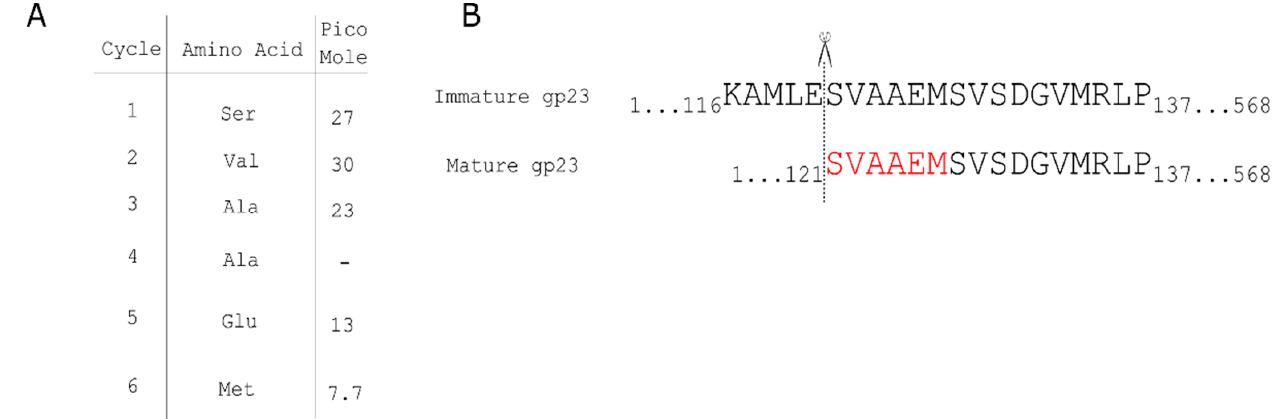
Figure 1. Edman degradation of P1 major capsid protein gp23. ( A ) Edman degradation reveals the first six amino acids of the N-terminus of gp23 purified from P1 virions. ( B ) The amino acids identified in the open reading frame of gp23, in which the first 120 residues are processed from the gp23 N